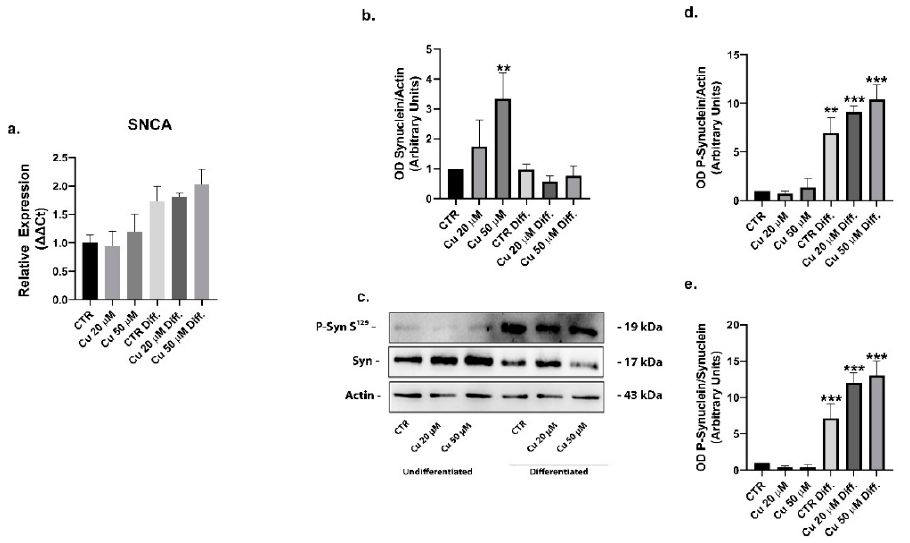
Figure 8. Copper treatment increased phospho- α -synuclein levels in differentiated SHSY5Y cells. mRNA relative expression of α -synuclein gene (SNCA) in undifferentiated and differentiated cells incubated with 20 or 50 µ M copper ( a ). Representative immunoblots of the α -synuclein and phospho- α -synuclein protein ( c ) and densitometric analysis of bands representing means ± SD of three independent experiments ( b , d , e ). β -actin was used as loading control. Values were compared with untreated cells (CTR) by one-way ANOVA following Tukey test ** p < 0.0021 *** p < 0.0002. To justify this result, the cellular expressions of PLK2 kinase, involved in phosphoryla- tion at the residue S129 of α -synuclein and the relative phosphatase PP2A, were analyzed. PP2A western blots did not show a significant variation between the different conditions (Figure 9b,c), whereas the expression of PLK2 was upregulated in both the untreated and copper treated differentiated cells (Figure 9a).